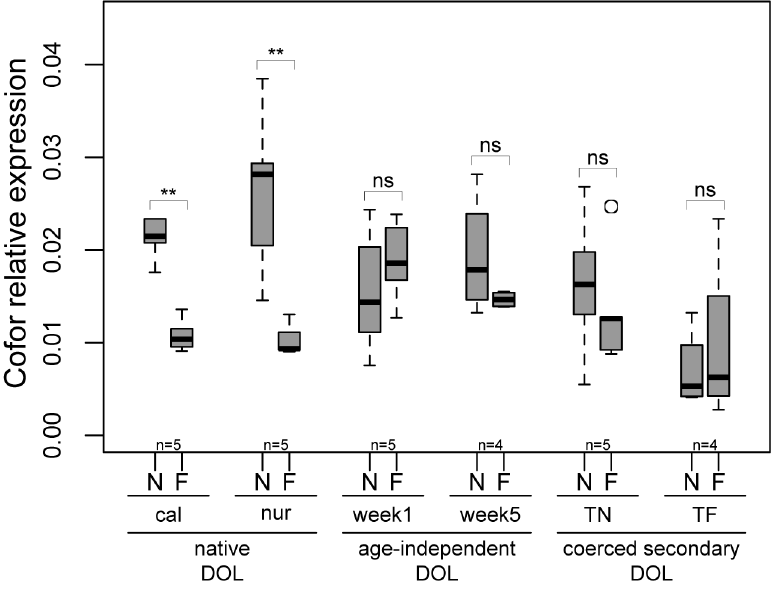
Fig 1. Relative Cofor expression comparing nurses (N) and forager (F) expression. “ cal ” = callows performing nursing tasks vs. foragers; “ nur ” = age-unknown nurses vs. foragers; “ week1 ” = 1 week-old nurses vs. foragers; “ week5 ” = 5 week-old nurses vs. foragers; “ TN ” = Age-unknown workers engaged in the task nursing and challenged to precocious foraging behavior; “ TF ” = Age-unknown workers engaged in the task foraging and challenged to revert to nursing behavior; DOL = division of labor. ** = p < 0.008, ns = p > 0.05. The number of replicate colonies is given below each box; each replicate represents five pooled nurse and worker heads,